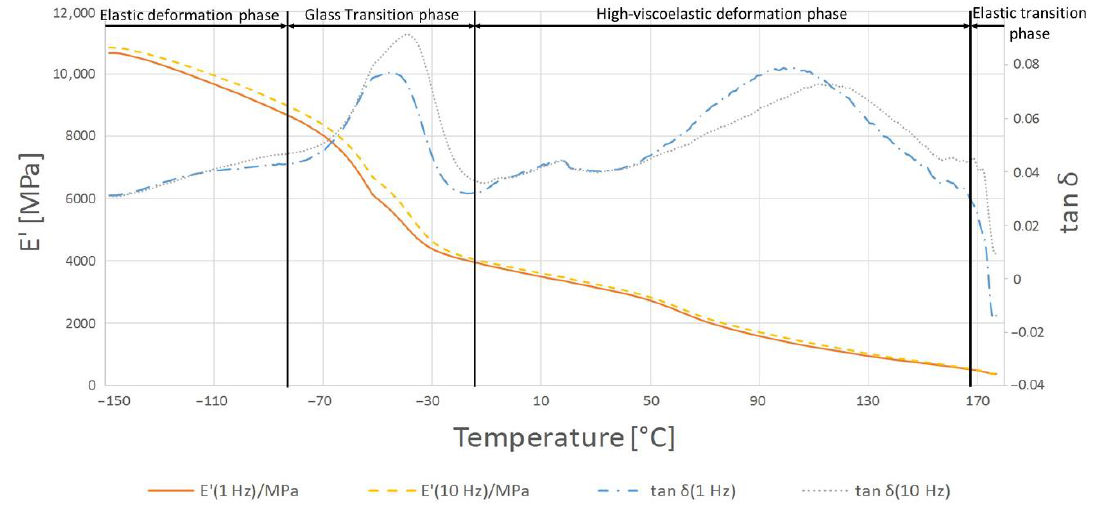
Figure 8. Results of DMTA test for PVDA Tecaflon.